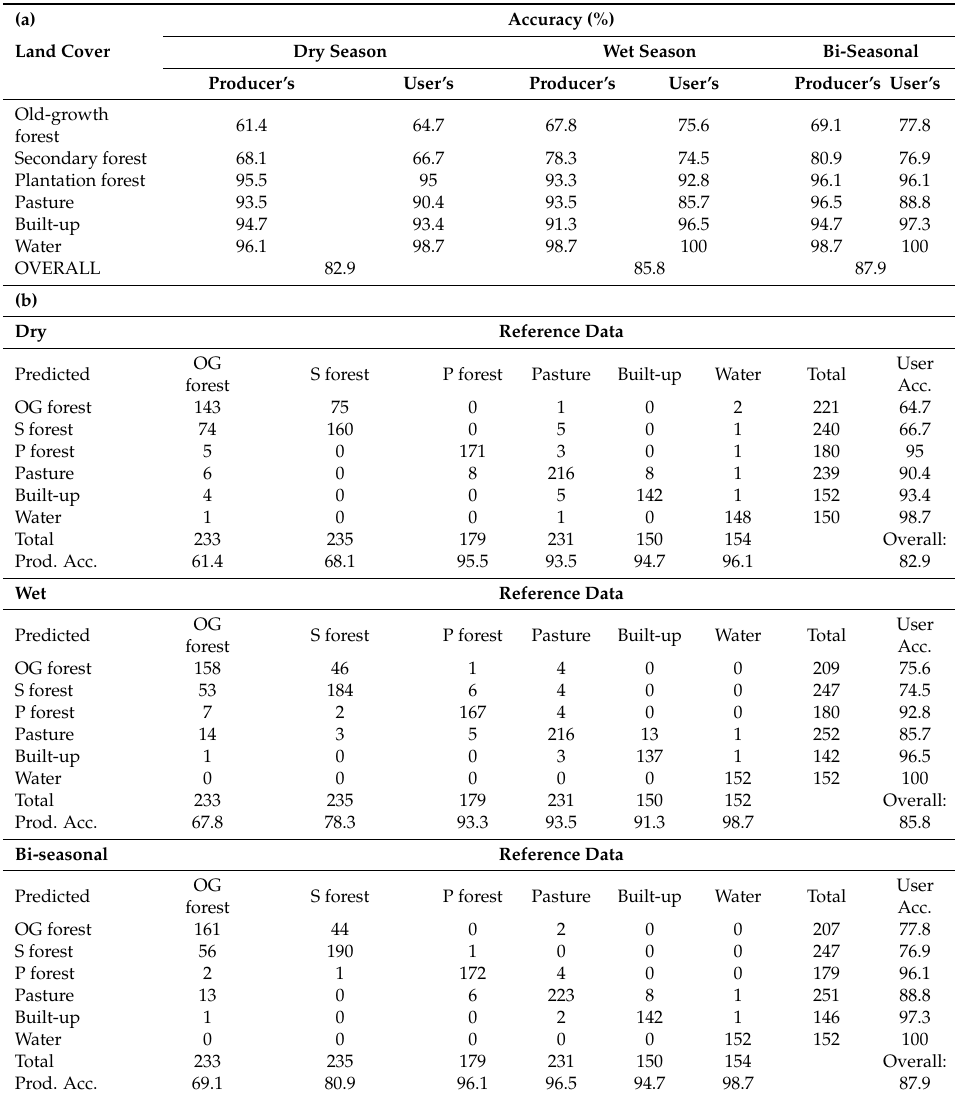
Table 3. Overall producer’s and user’s accuracies ( a ) and confusion matrices ( b ) for the three Random Forests (RF) models with secondary forest data derived from change trajectories